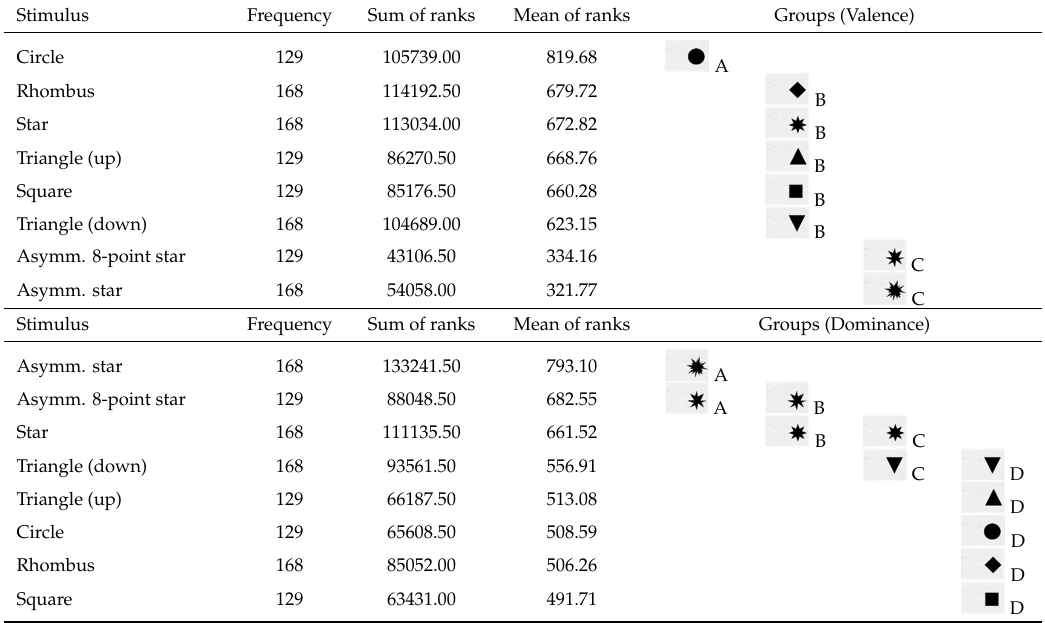
Table 3. Results of multiple pairwise comparisons of map stimulus set 1 indicating groups of similar valence and dominance.